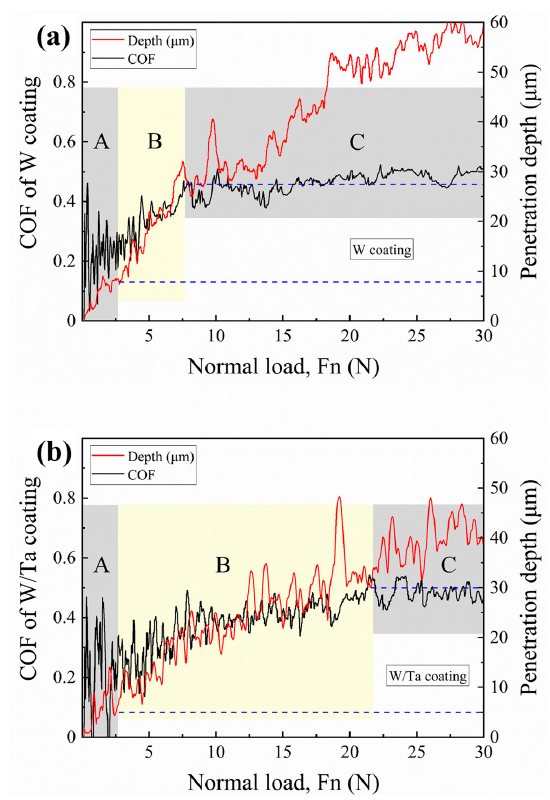
Figure 10. Variation of normal force, CoF, and penetration depth during the scratch experiment for ( a ) W coating and ( b ) W/Ta coating.